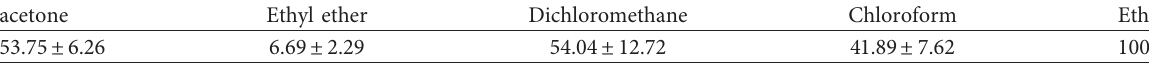
Table 1: Recovery of TMEA with different extraction solvents (%, n � 6).